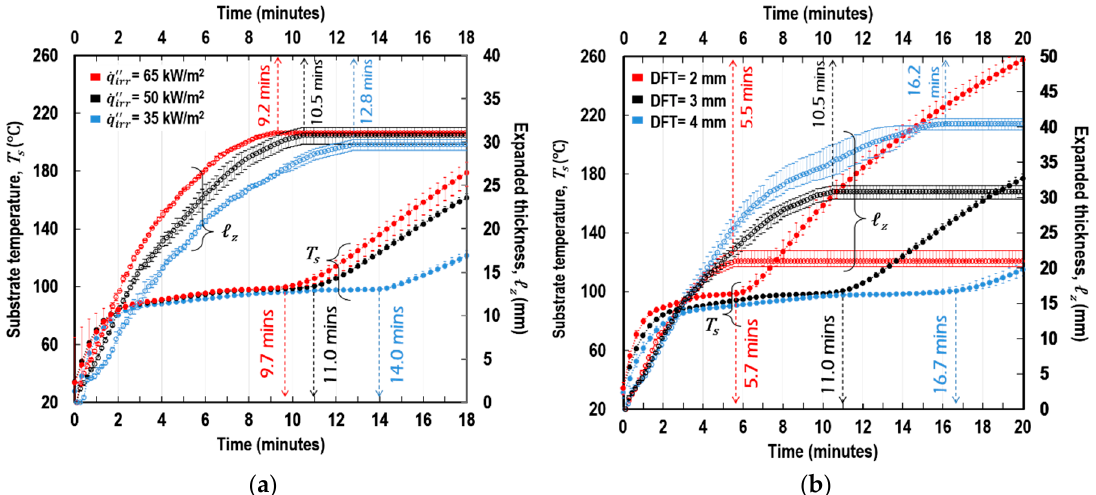
Figure 15. Experimental measurements of substrate-temperature ( T s ) and thickness expansion ( ℓ z ) over time: ( a ) at DFT = 3 mm and ( b ) at 𝑞(cid:4662) (cid:2919)(cid:2928)(cid:2928)(cid:4593)(cid:4593) = 50 kW/m 2 .